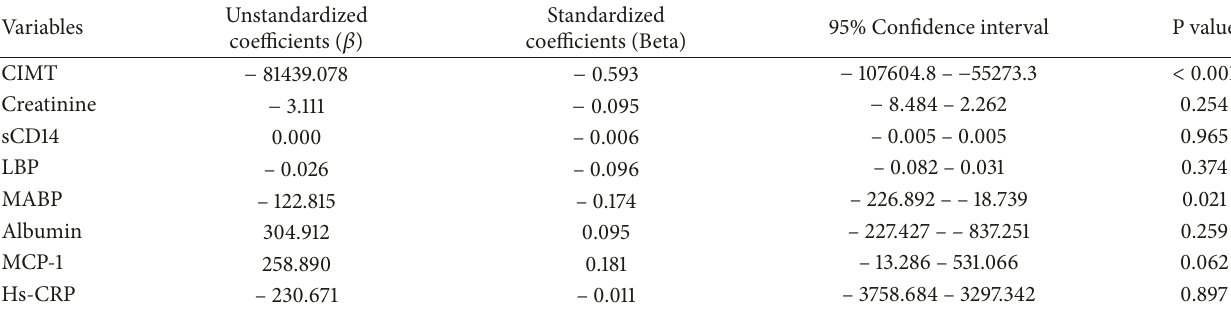
Table 3: Multiple linear regression analysis of determinants of serum TGF- 𝛽 1 levels.